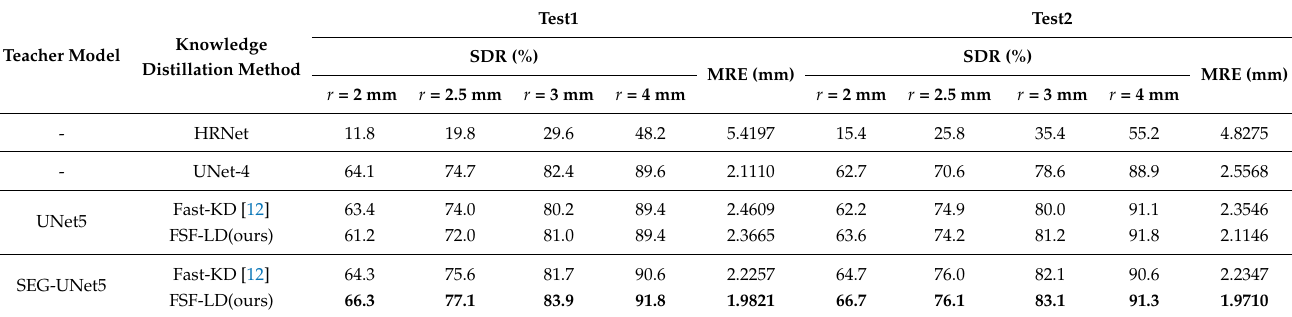
Table 5. 2D hip radiograph dataset: The comparison results for our proposed KD method on the 2D hip radiograph dataset. The student model is UNet4, while the teacher model is UNet5 and